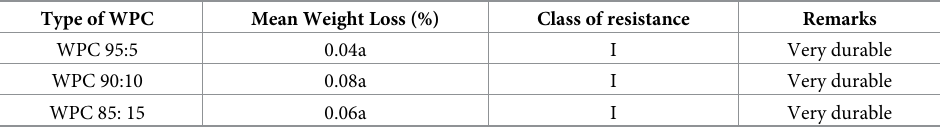
Table 6. Resistance of WPC from termite bait.